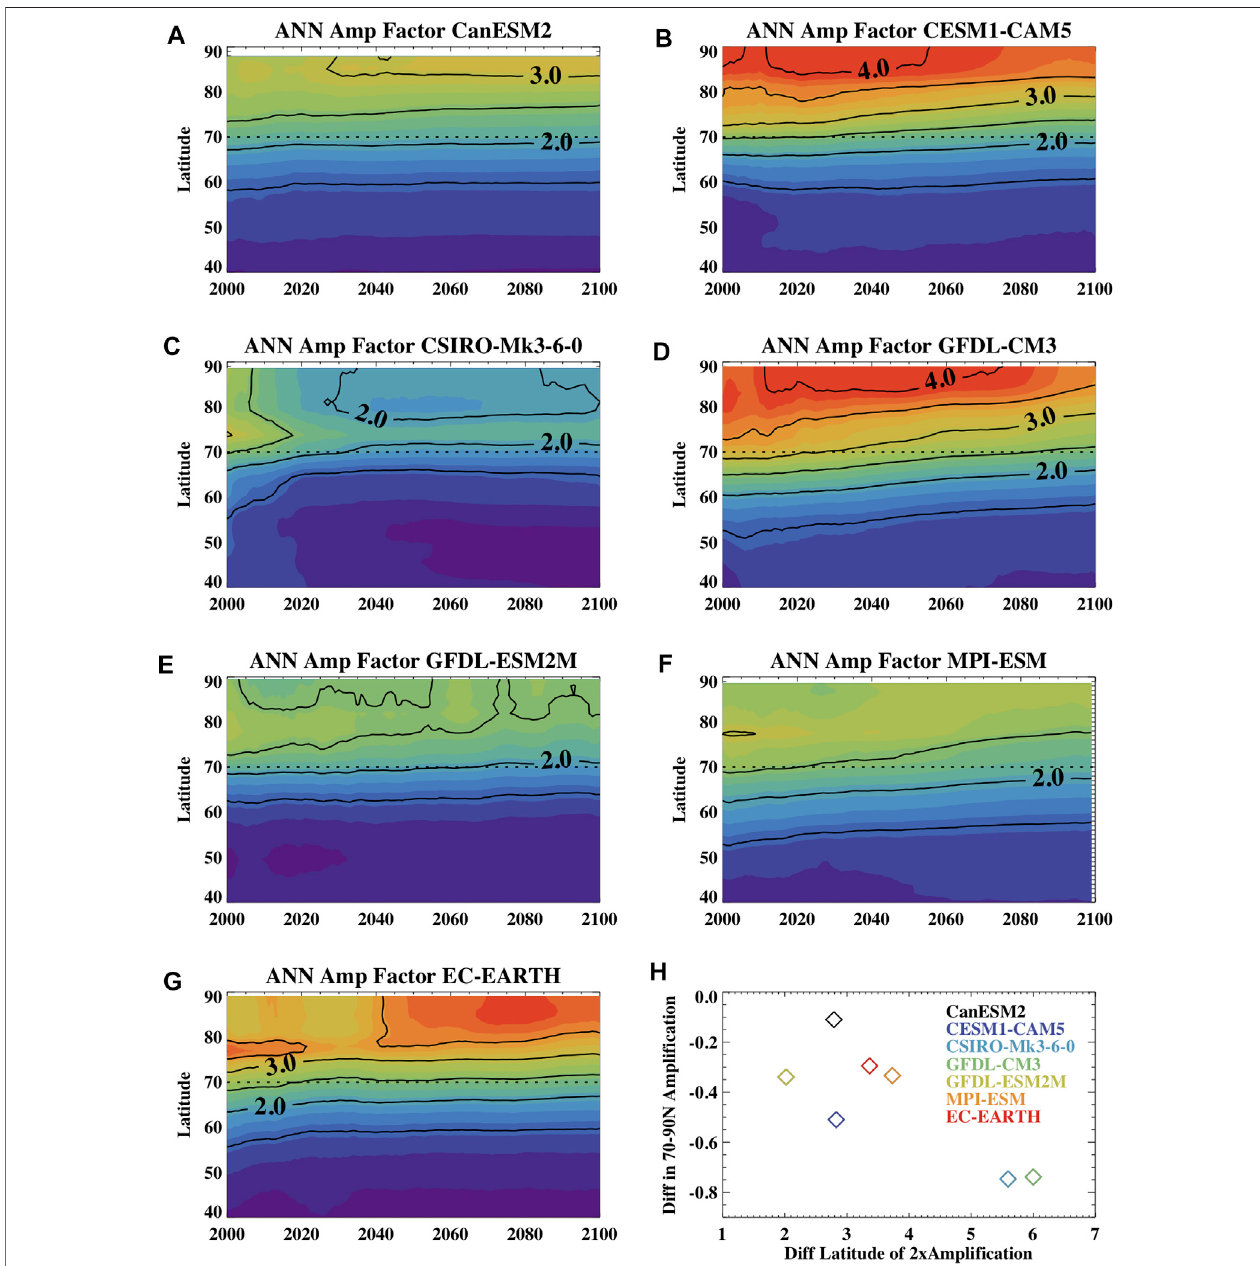
FIGURE7| Theensemblemeanannualmeanampli fi cationfactorforthedifferentSMILESoverthe21stcenturyasafunctionofyearandlatitudefor (A) CanESM2, (B) CESM1-CAM5, (C) CSIRO-Mk-3-6-0, (D) GFDL-CM3, (E) GFDL-ESM2M, (F) MPI-ESM, and (G) EC-EARTH. The lined contour interval is 0.5. Panel (H) shows the 21stcenturychange inthelatitudeat whichdoubled ampli fi cation occursrelative tothechangeinthe 70 – 90Nampli fi cation factor fortheensemblemeans from different SMILES. The 21st century change is computed as the ensemble mean values in 2099 minus that in 2000.